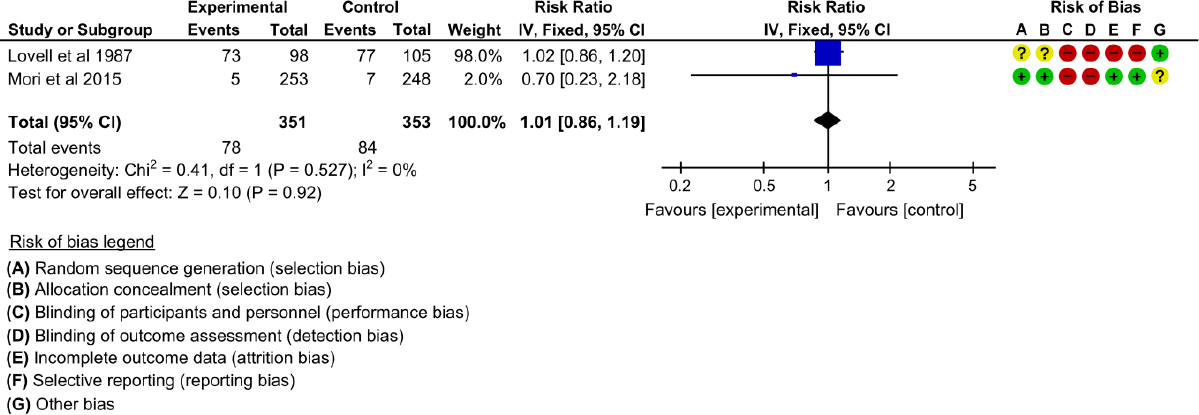
Figure 8. Meta-analysis for the effect of MCH handbook interventions vs. standard care on maternal smoking [19,22].